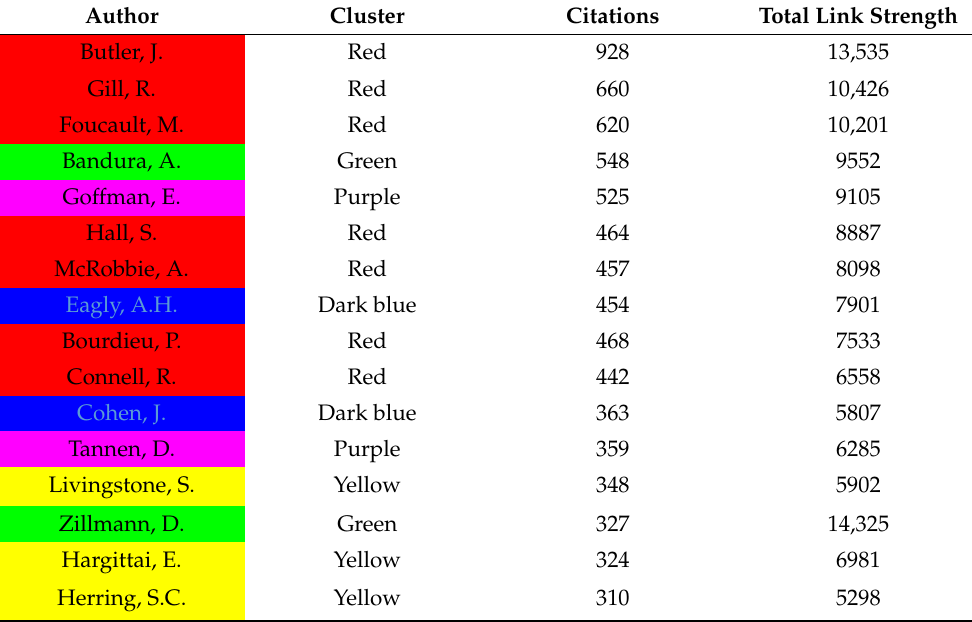
Table 4. Top 50 authors based on